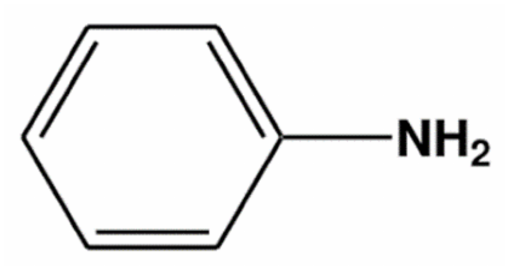
Figure 2. Aniline